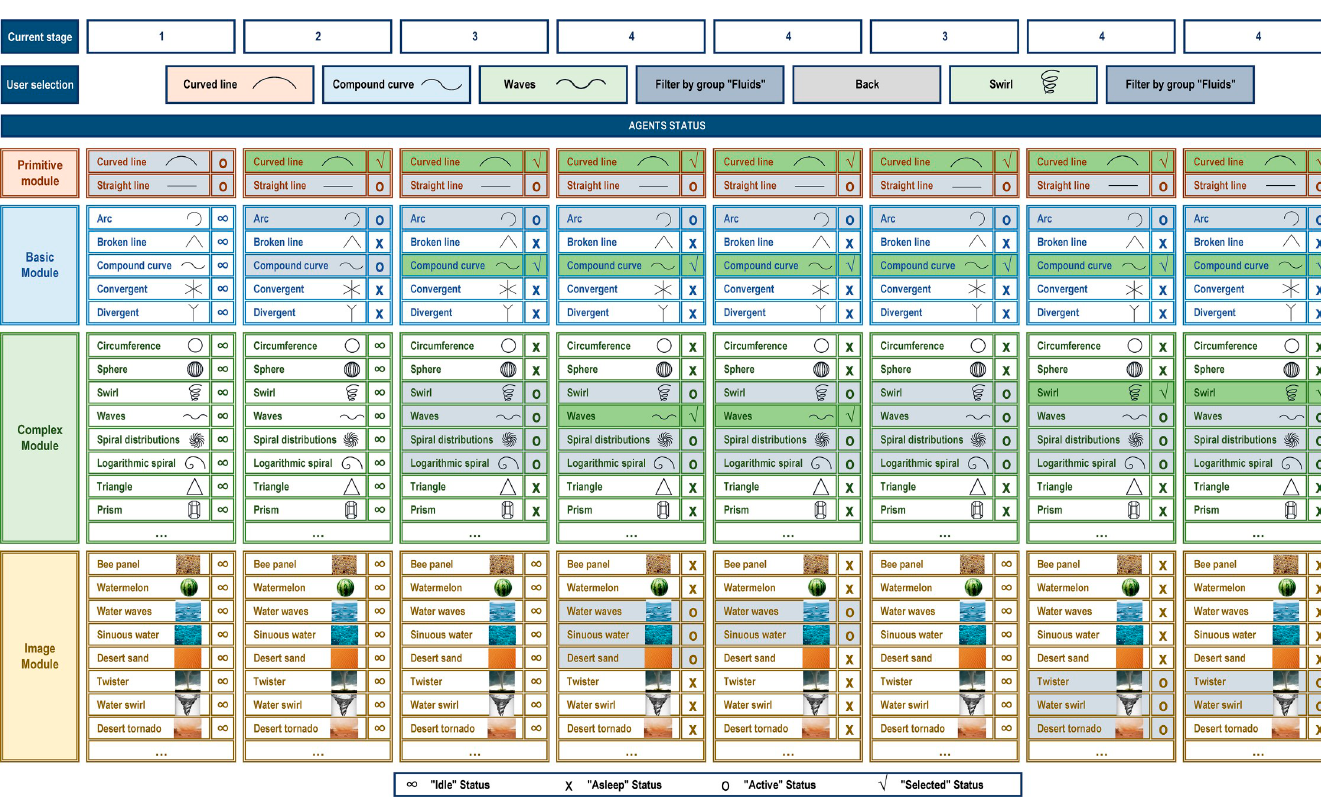
Fig 6. Detail of agent states when searching for ideas to design a perfume